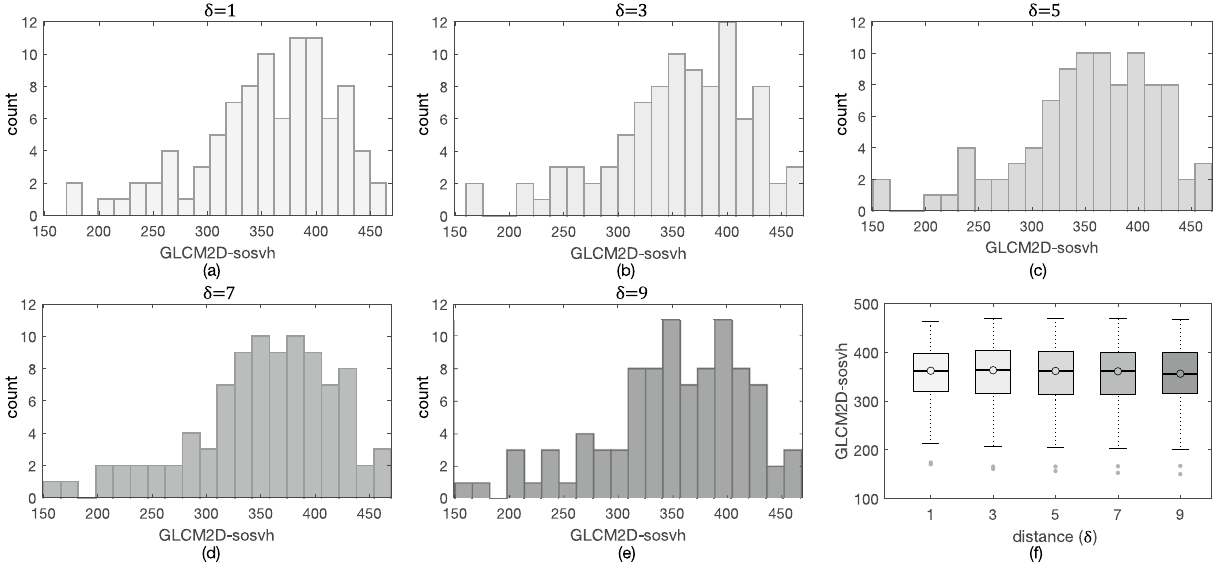
Figure 4. Histograms of GLCM2D- sosvh computed from δ = 1 to δ = 9 ( a – e ) did not show any relevant difference. In addition, boxplots ( f ) confirmed no statistical significance at ANOVA test ( p